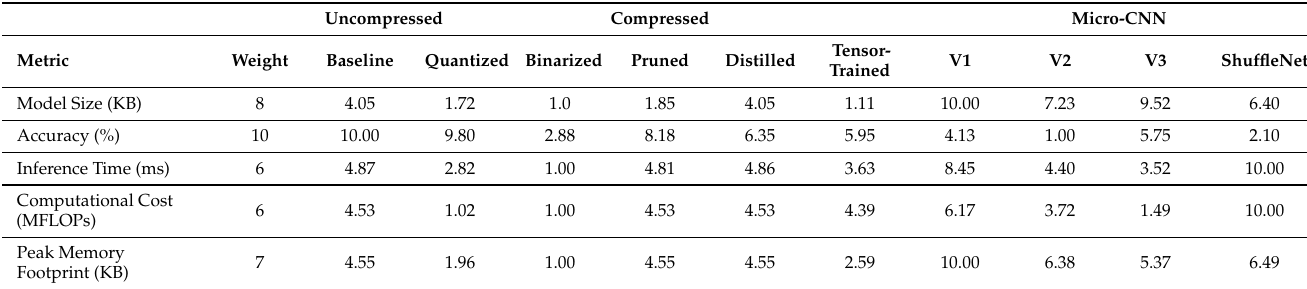
Table 3. Weighted relevance score assigned to evaluation criteria and model results scaled to (1–10), which corresponds to evaluation metrics’ scale